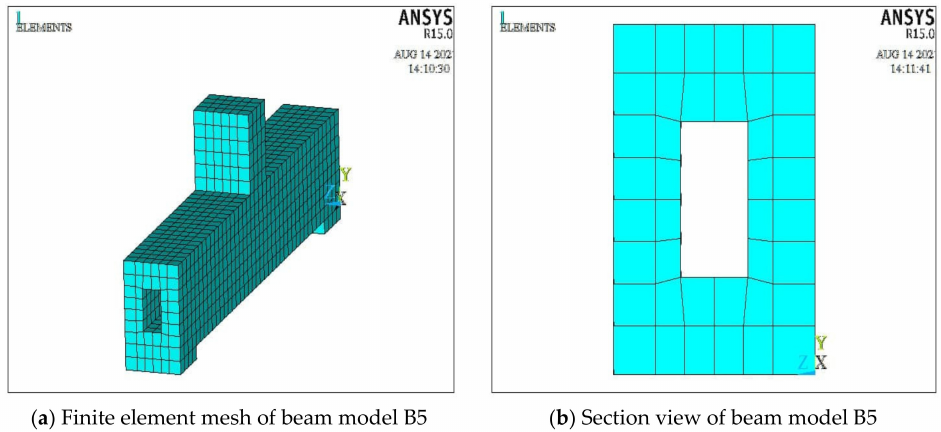
Figure 5. 3D view of beam model B5 and section view of beam model B5 with the hollow core area ratio of